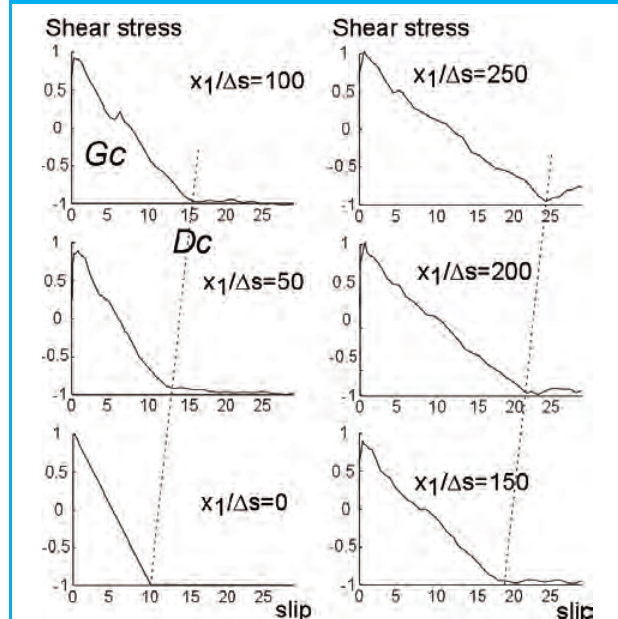
Figure 5. Slip-shear stress relationship in macroscopic scale. Each panel shows the shear stress as the function of slip obtained for equally lspaces sampling points along main fault. The dimension of the triangle corresponds the fracture energy G c (after Ando,